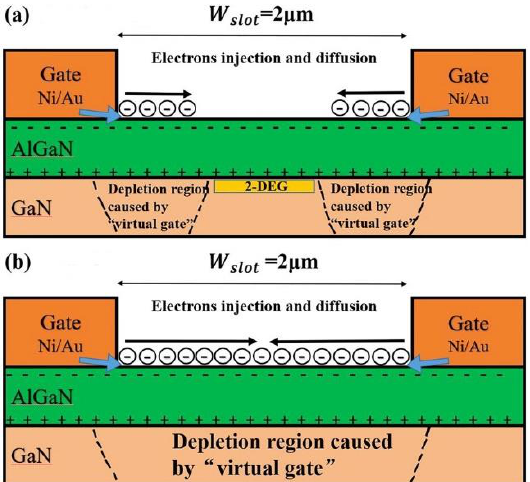
Figure 33. The device layout illustrates ( a ) electron injection in the slot region and the virtual gate in both areas. ( b ) the devices become fully virtual gates. Reproduced with permission [159]. Copyright 2019, the author (s), Published by AIP Publishing.